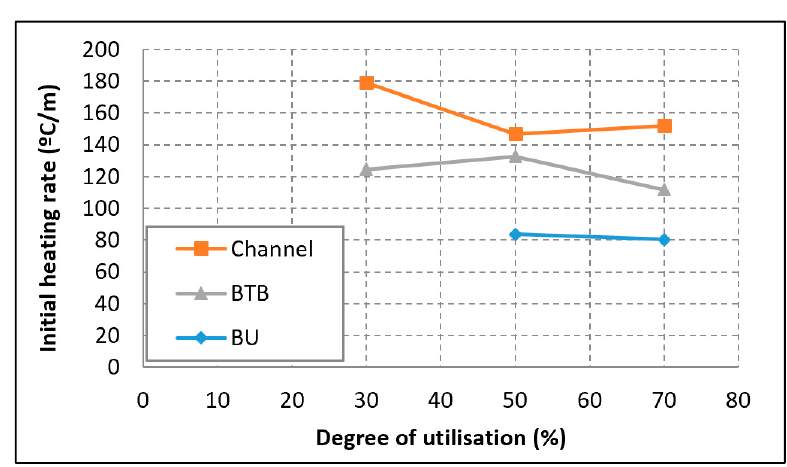
Figure 16. The average heating rates.